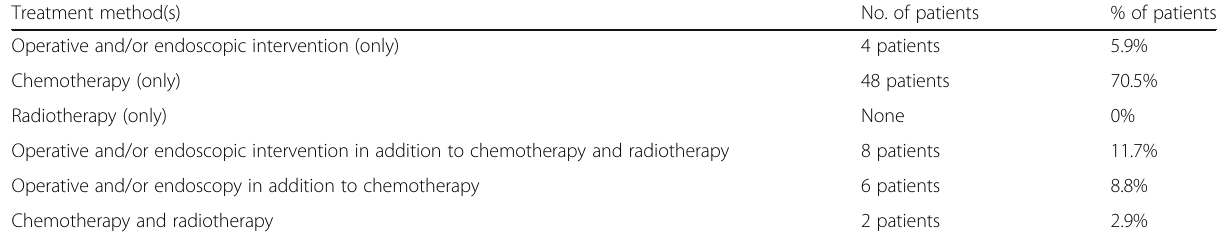
Table 4 Treatment methods for the patients in the study with their number (No.) and percentage (%) Treatment method(s)